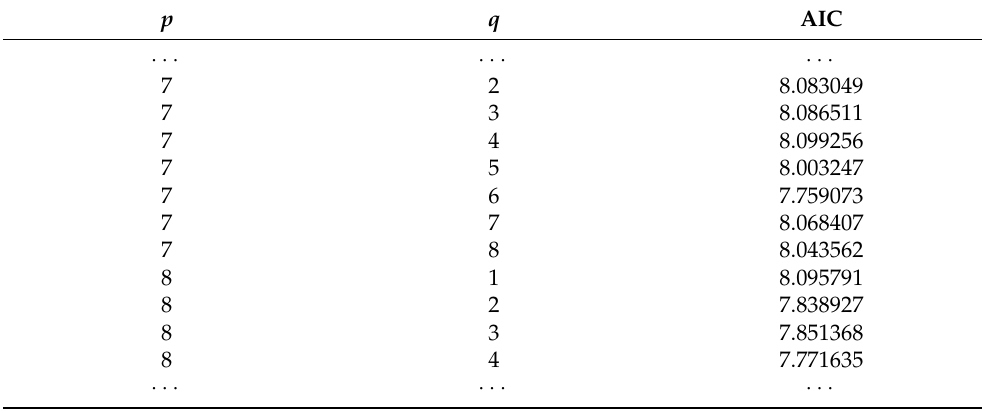
Table 2. AIC under different p , q